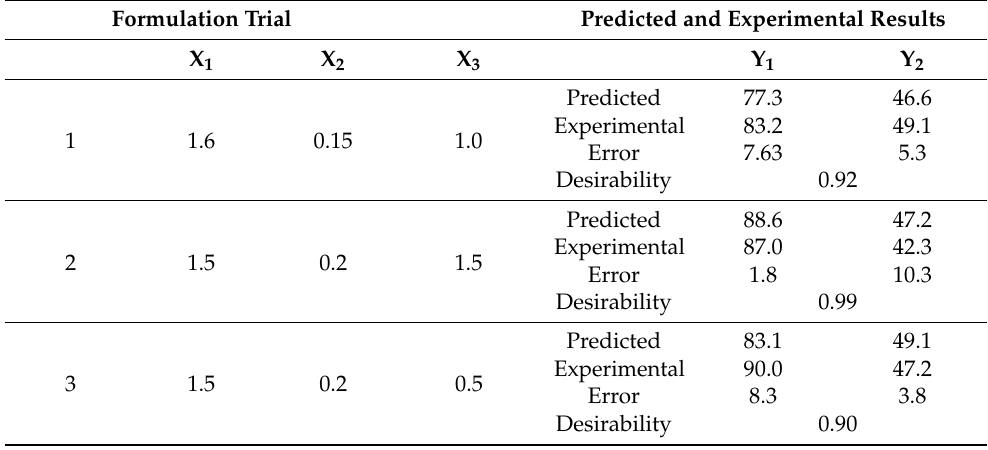
Table 6. The experimental and the predicted results of the optimum co-milled CXB composition based on desirability function.